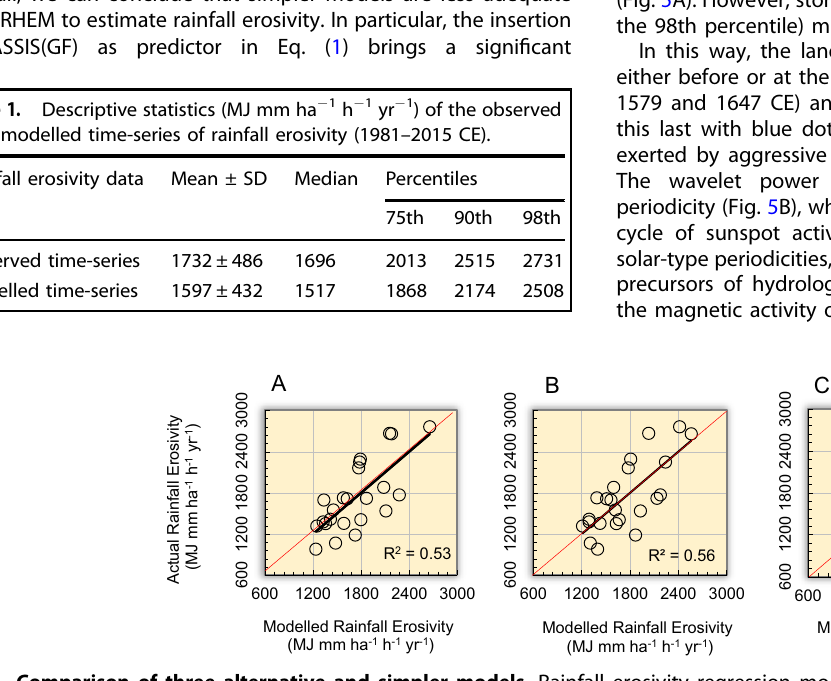
Fig. 4 Comparison of three alternative and simpler models. Rainfall erosivity regression model with an annual amount of precipitation ( A ), linear regression with summer and autumn amount precipitation ( B ) and multiple linear regression with summer and autumn precipitation ( C ), versus actual rainfall